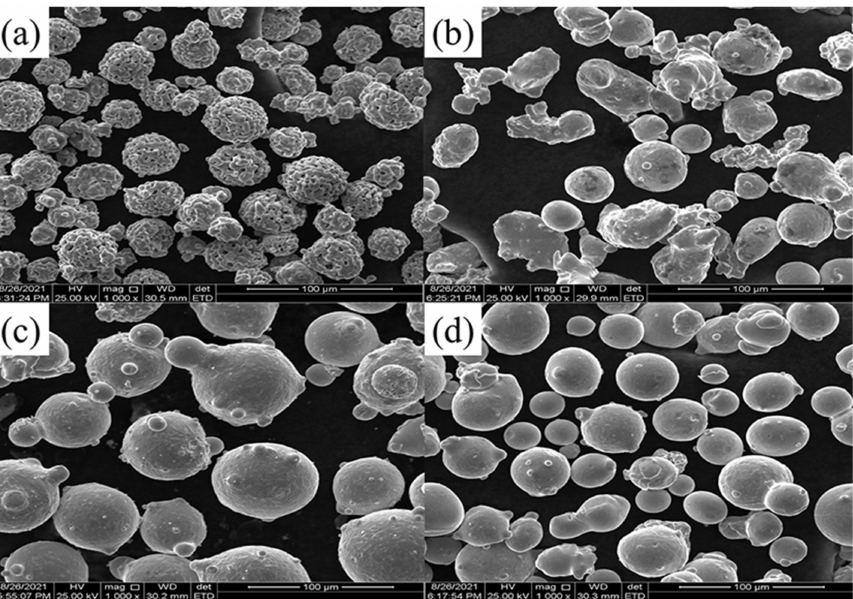
Figure 1. The SEM of used metal powder: ( a ) Cr 3 C 2 –NiCr; ( b ) NiCr; ( c ) Ni625 of LC and ( d ) Ni625 of